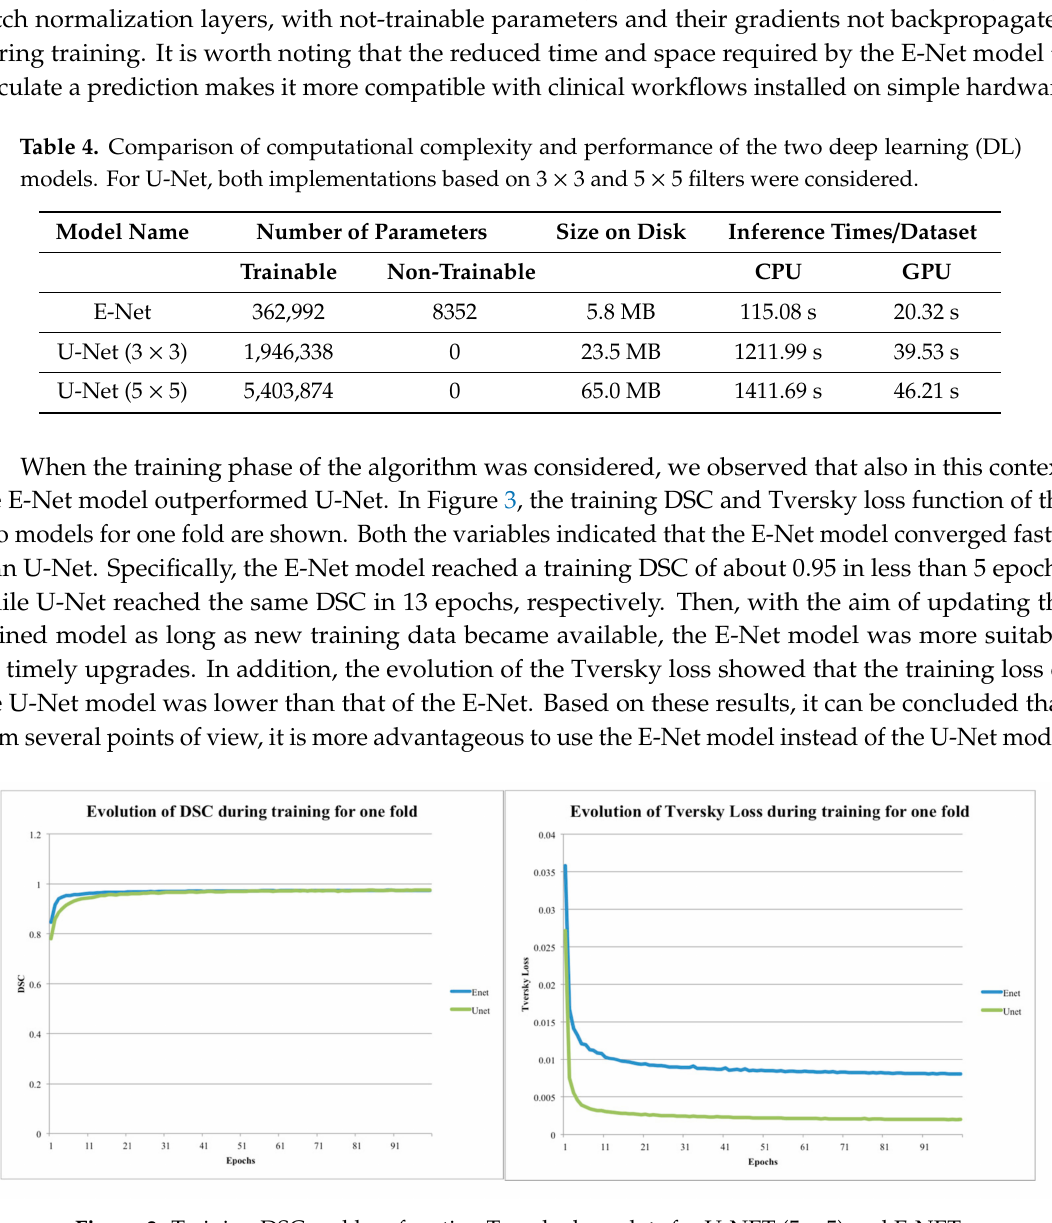
Figure 3. Training DSC and loss function Tversky loss plots for U-NET (5 × 5) and